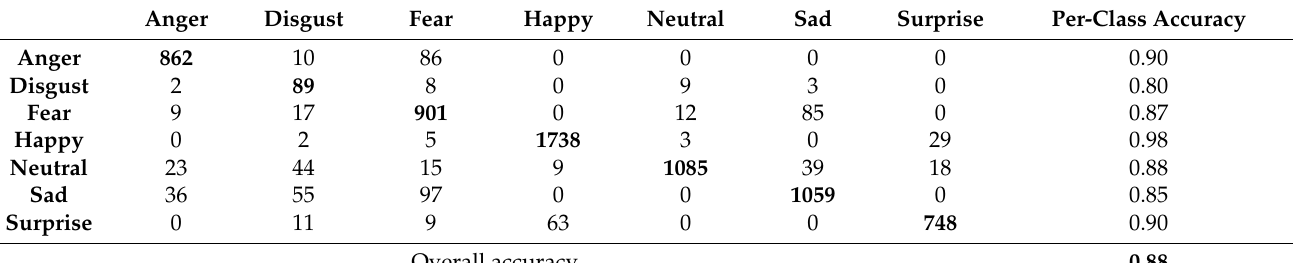
Table 7. Cross-validation over the FER-2013 dataset.